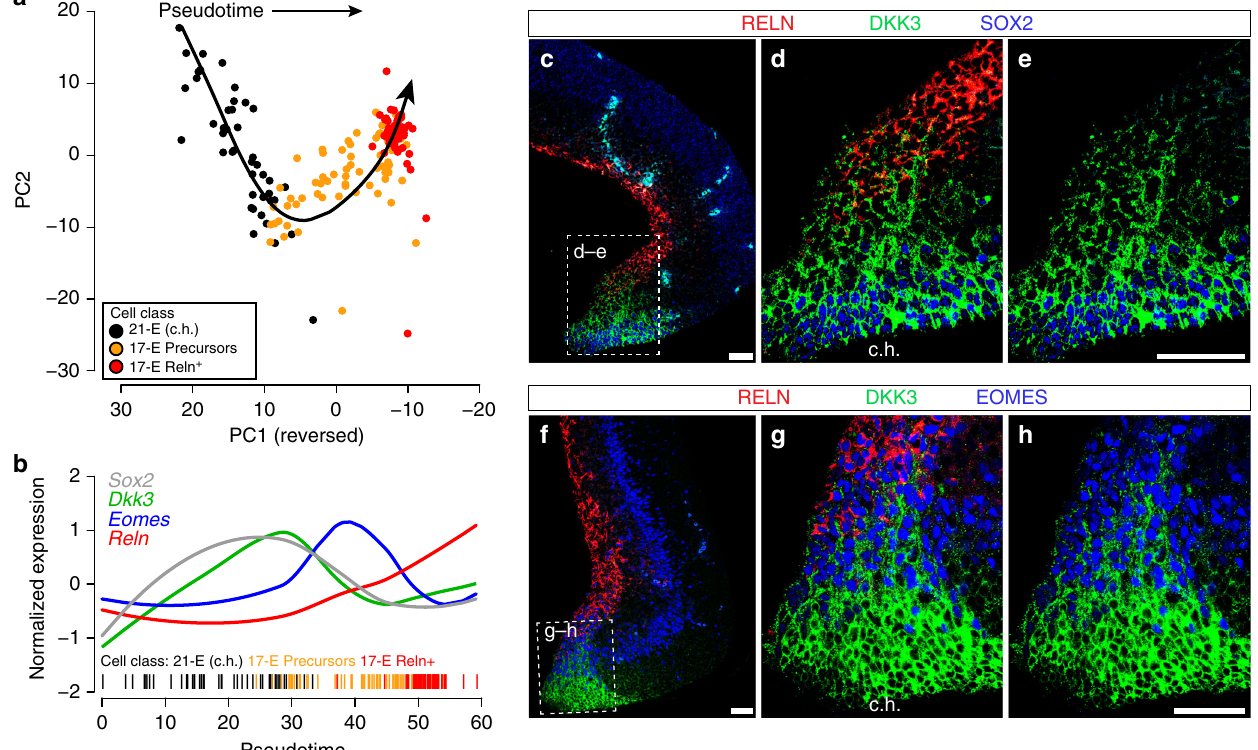
Fig. 3 Empirical validation of Layer I sub-clusters in the E14.5 cortex. a Pseudotiming analysis of cortical hem (c.h.) cells (Cluster 21-E), and Reln + and precursor-like sub-clusters of Layer I cells. The curvilinear trajectory was fi t using Slingshot on a Principal Components Analysis of gene expression Z- scores. b Loess-smoothed Z-scored gene expression of four marker genes over pseudotime. c – e Co-staining of the cortical hem (boxed) with DKK3 (green), SOX2 (blue), a marker of multipotent neural stem cells, and RELN (red), a marker of differentiated Layer I neurons. Scale bar represents 50 μ m. f – h Co-staining of the cortical hem with DKK3 (green), EOMES/TBR2 (blue), a maker for intermediate neuronal precursors, and RELN (red). Scale bar represents 50 μ